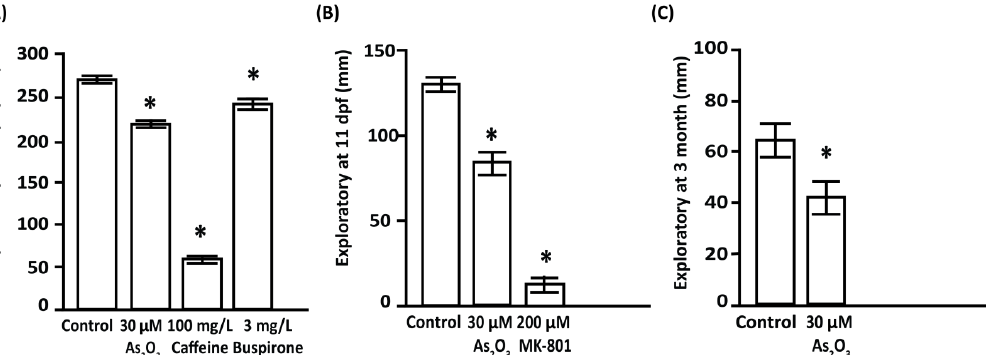
Figure 3. Effects of long-term impairment of 30 µ M As 2 O 3 exposure on exploratory activity. Exploratory activity was persistently decreased in larvae from 6 dpf ( A ) and 11 dpf ( B ) to adult stage ( C ). Data are presented as mean ± SEM, ( ∗ p ≤ 0.005), n = 30 larvae per group, n = 22 adults per group), with significant differences relative to the control group, ∗ ( p ≤ 0.05).